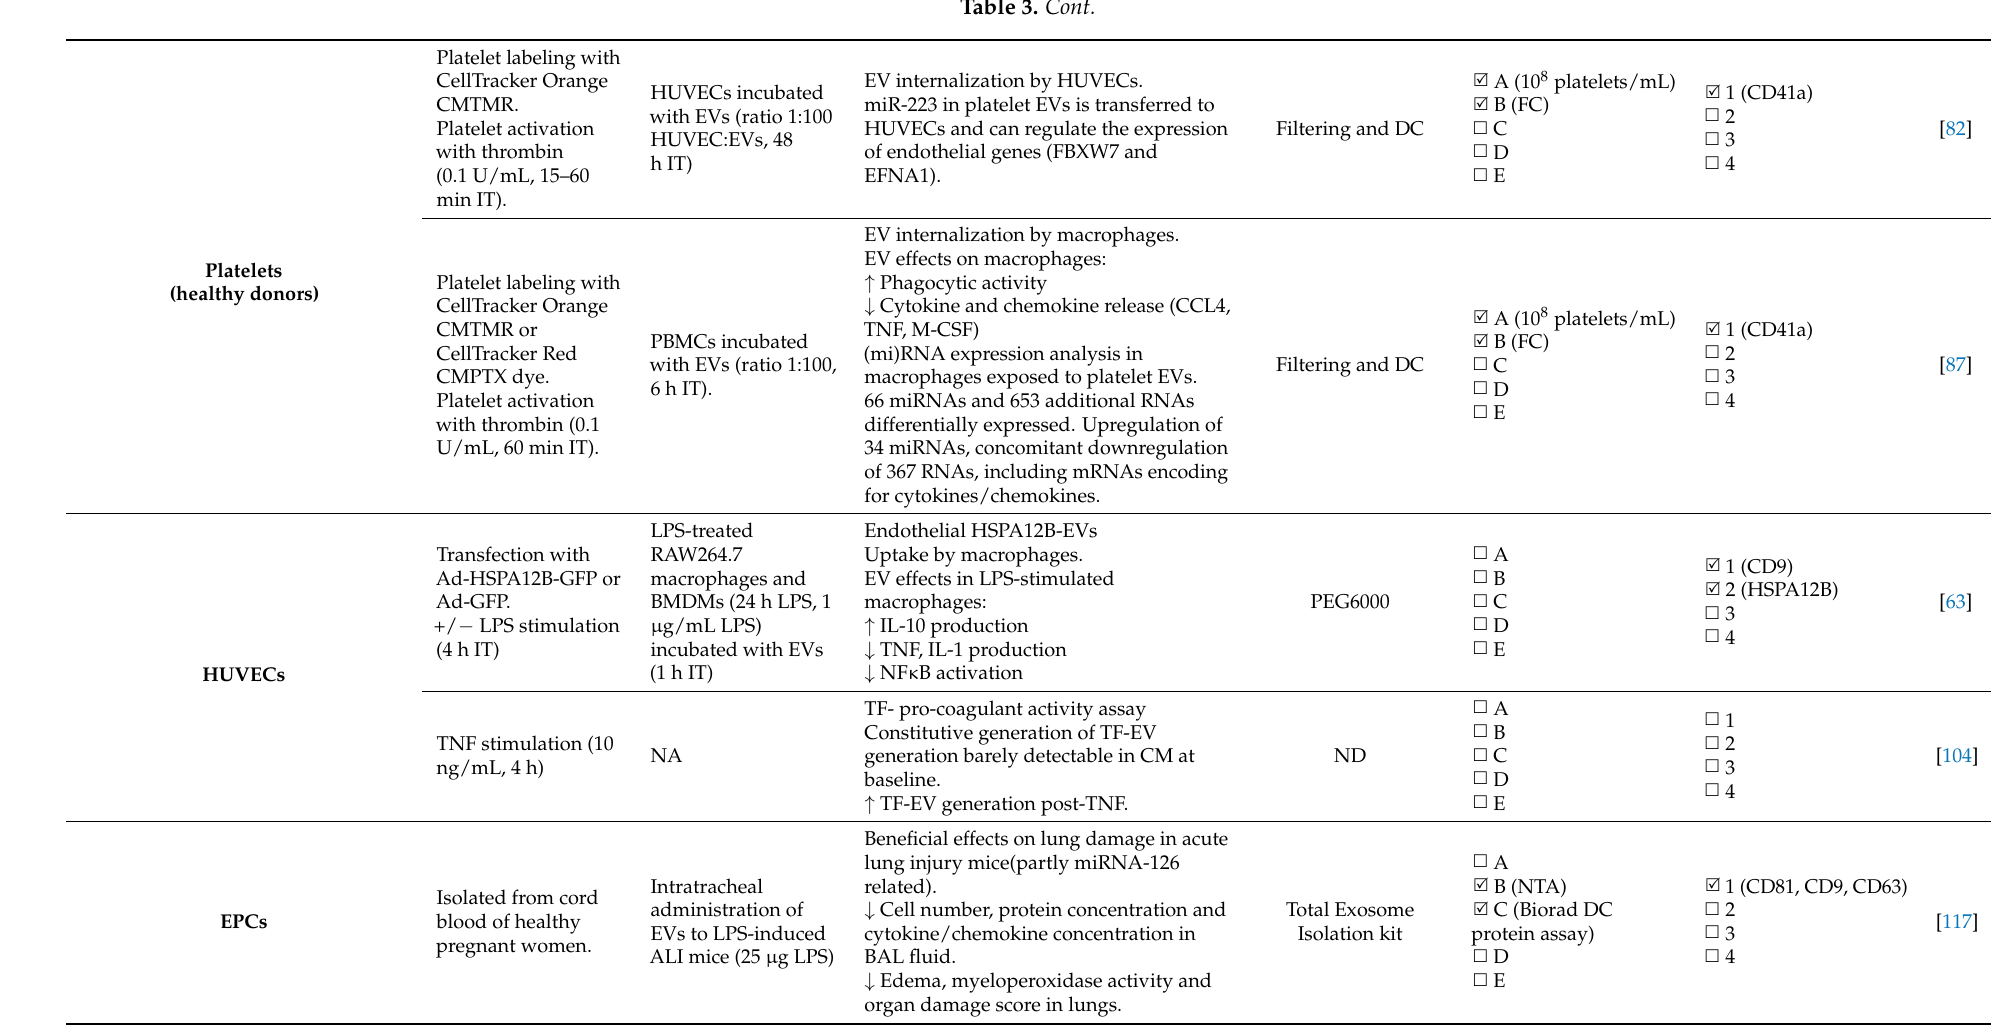
↑ PS-EVs Combination of prothrombin time, EC-derived CD105+ EVs and platelet count at D1 could predict DIC ab-